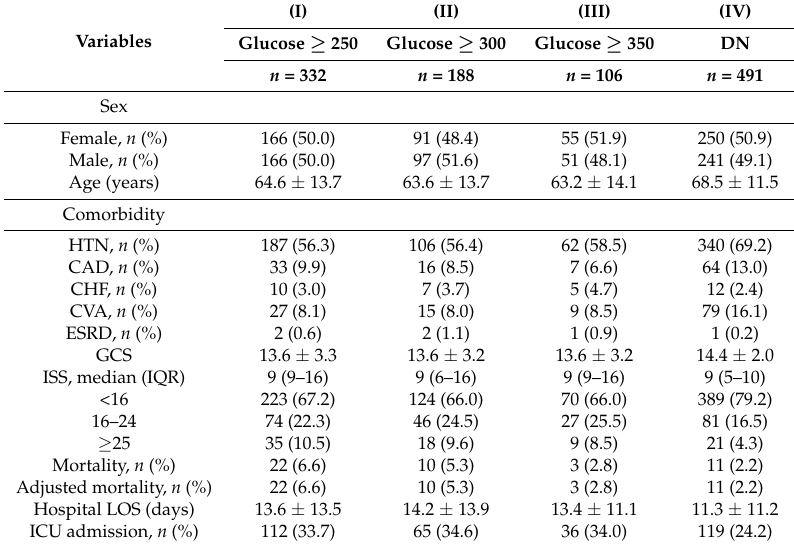
Table 2. Characteristics, injury severities, and outcomes of SIH in diabetes based on defined glucose levels set at 250 mg/dL, 300 mg/dL, and 350 mg/dL as well as patients with diabetic normoglycemia.